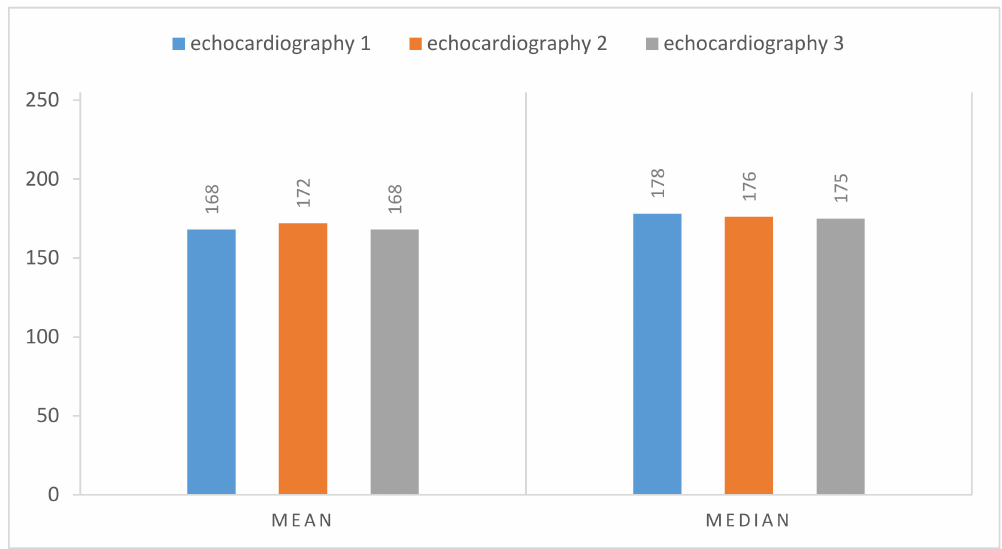
Figure 9. Threshold values of pixel intensity for calcium, extracted from echocardiographic images with different post-processing gains. Windrow Levels (WL): (1) WL = 75, (2) WL = 100, and finally, (3) WL = 125, all with a fixed Window Width of